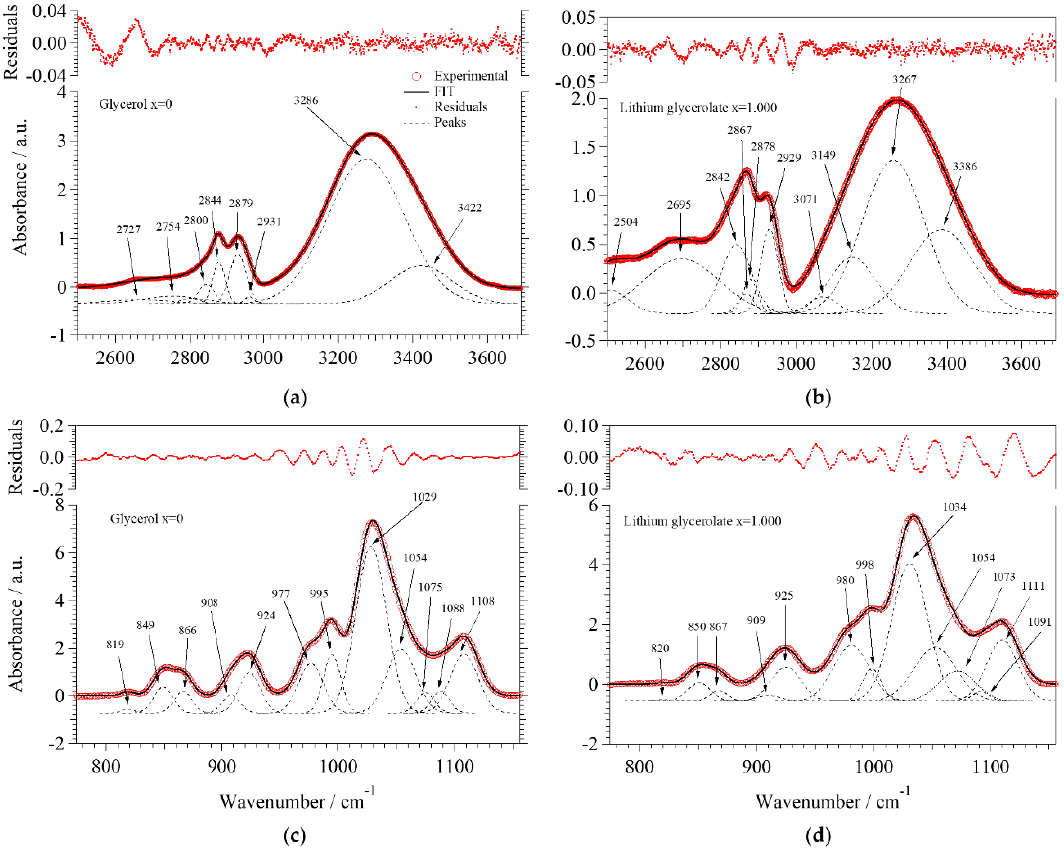
Figure 4. Gaussian fitting of the FT-IR spectra of ( a ) pristine glycerol, Gly (x = 0), in the 2500–3700 cm −1 region; ( b ) lithium glycerolate, GlyLi (x = 1.000), in the 2500–3700 cm −1 region; ( c ) pure glycerol, Gly (x = 0), in the 770–1150 cm −1 region; and ( d ) lithium glycerolate, GlyLi (x = 1.000), in the 770–1150 cm −1 region.